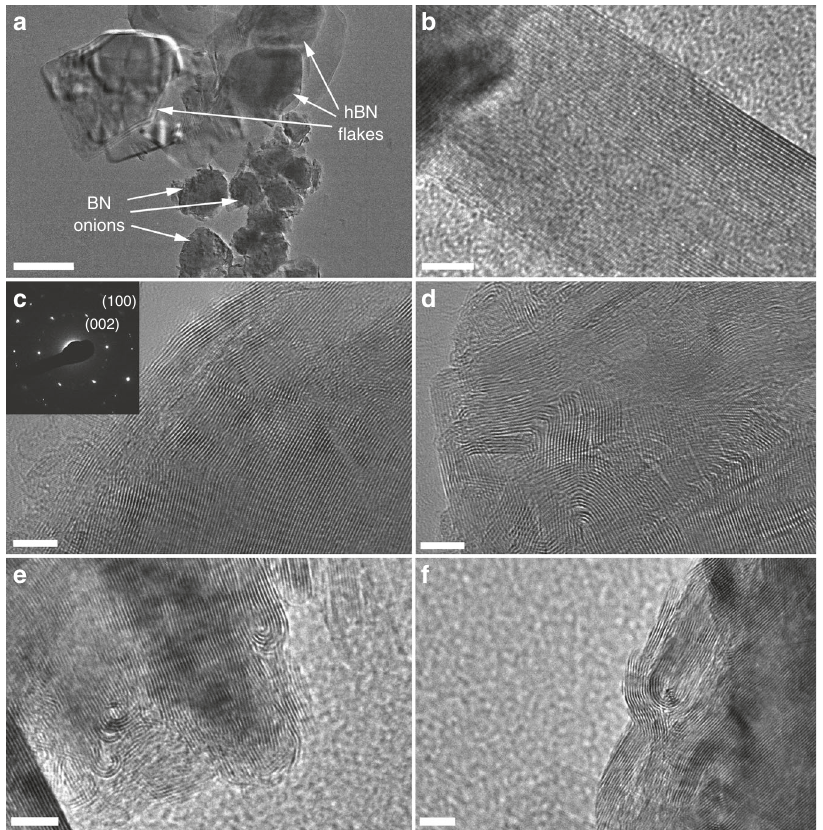
Fig. 3 TEM images of HSHBN-30 sample. TEM image of squashed BN onions and hBN fl akes ( a ); HRTEM images of hBN fl akes ( b ); BN onion associated SAED pattern ( c ), deformed and entwined BN onions ( d ), and the curly hBN layer shells stripped from the BN onions ( e , f ). The scale bar is 500 nm in a , and represents 5 nm in b – f